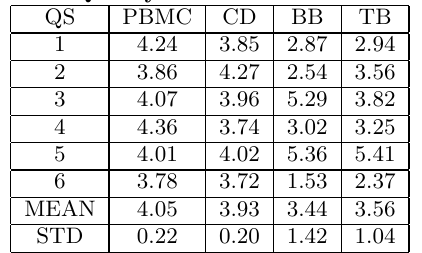
Table 4: Quality Smoothness for each